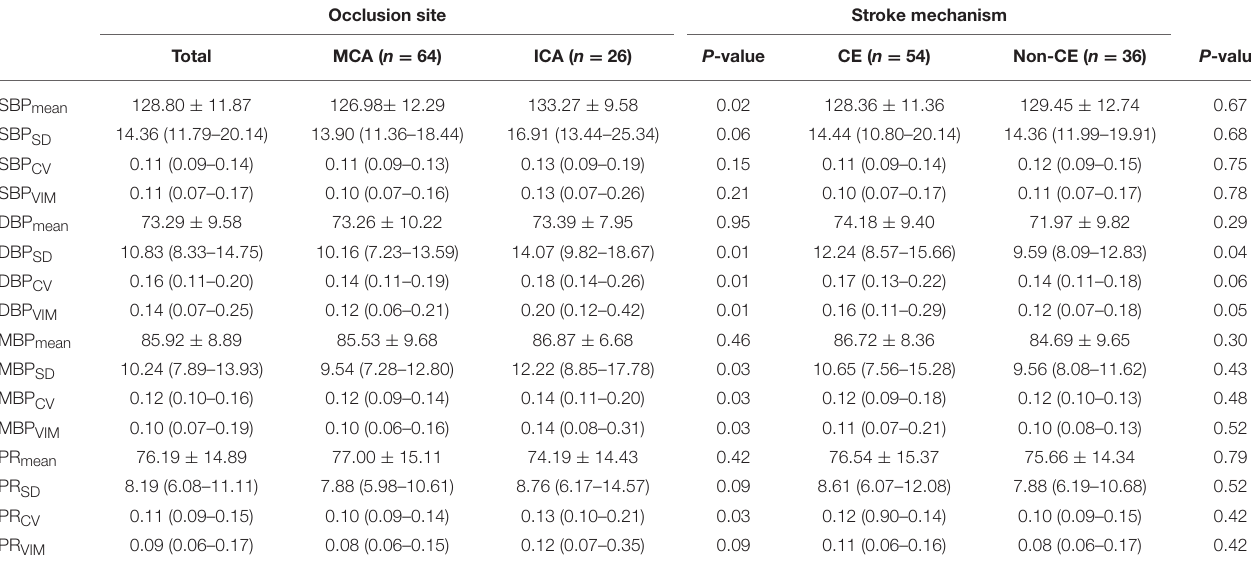
TABLE 2 | Comparison of BPV parameters according to the occlusion site, mechanism of stroke, and recanalization time. Occlusion site